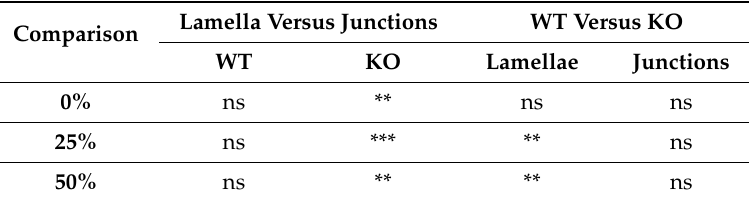
Table 3. Statistical